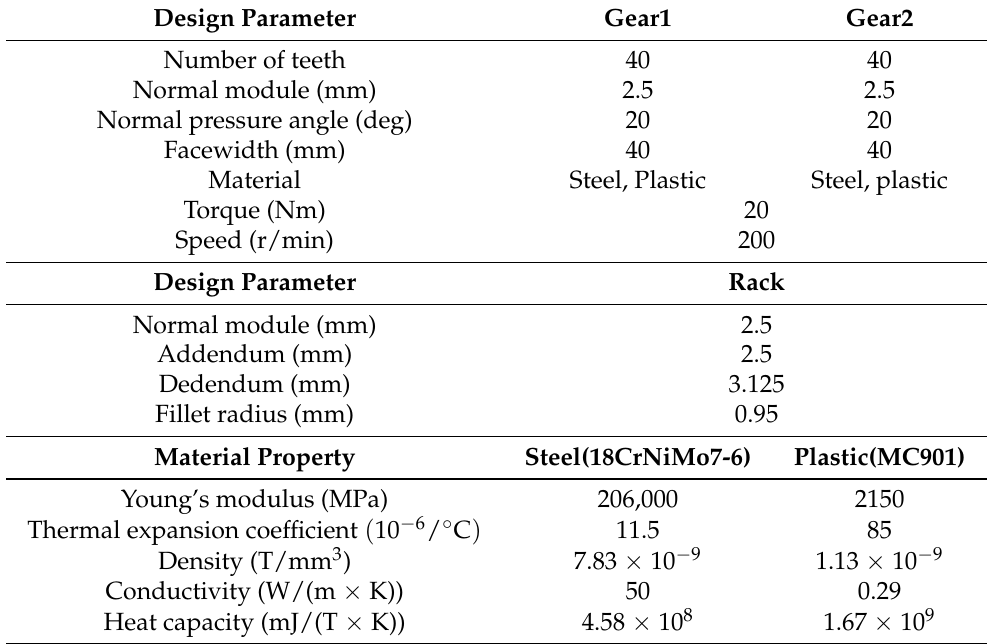
Table 1. Specification of a spur gear